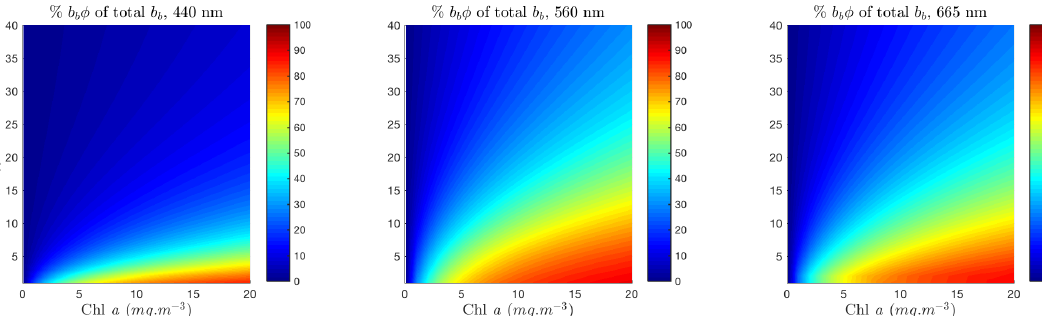
φ in the red and NIR. b